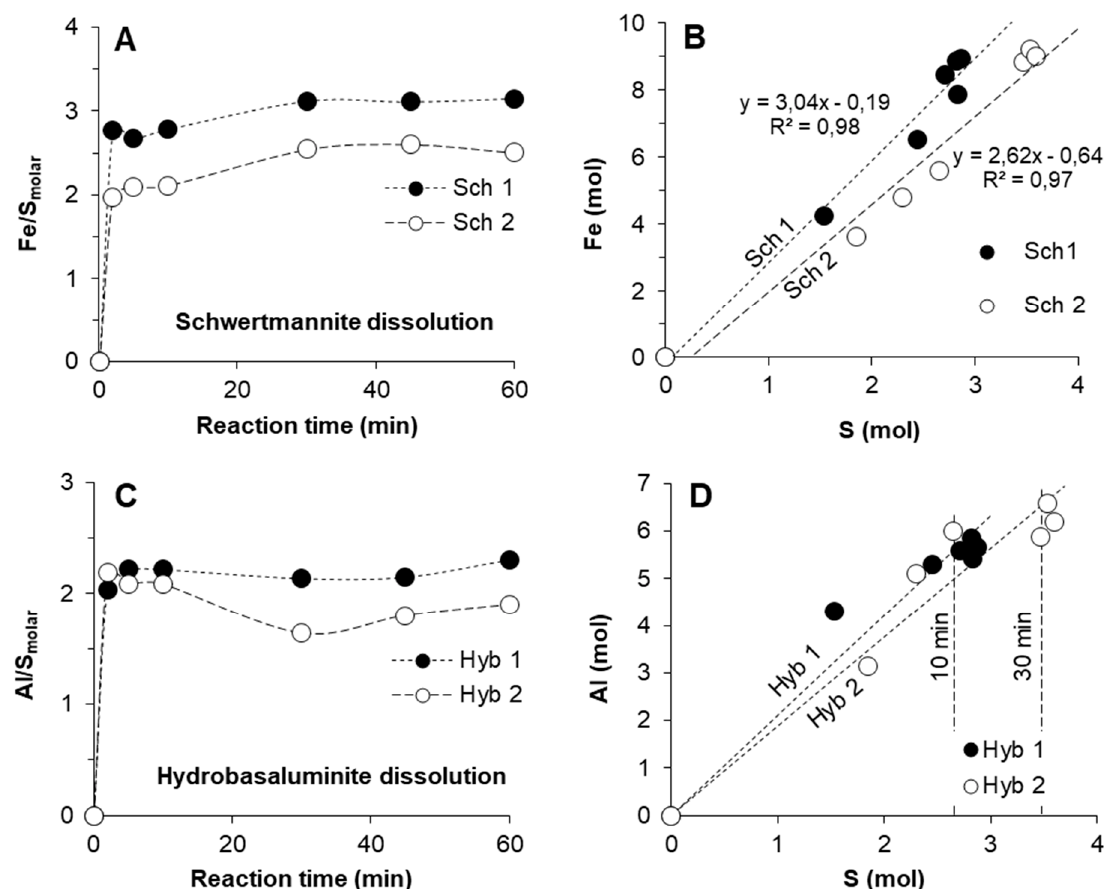
Figure 2. Temporal evolution of the Fe/S molar ratio ( A ) and Al/S molar ratio ( C ) during dissolution of schwertmannite (Sch) and hydrobasaluminite (Hyb), respectively, in ammonium oxalate solution at pH 3.0. The respective plots of Fe vs. S ( B ) and Al vs. S ( D ) are also indicated for these experiments.